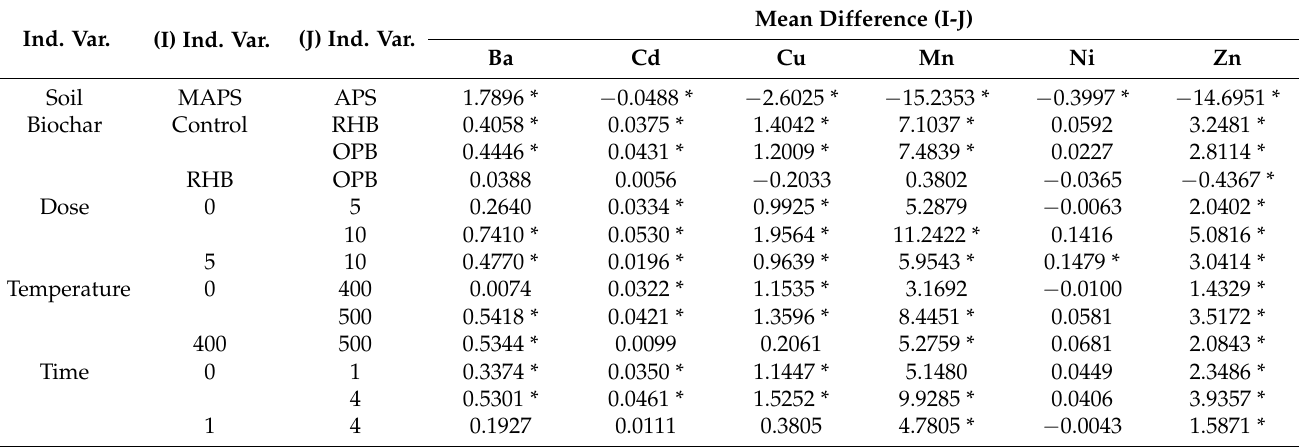
Table 4. Effects of independent variables on CaCl 2 -extractable trace elements (differences between means) after MANOVA analysis. Ind.